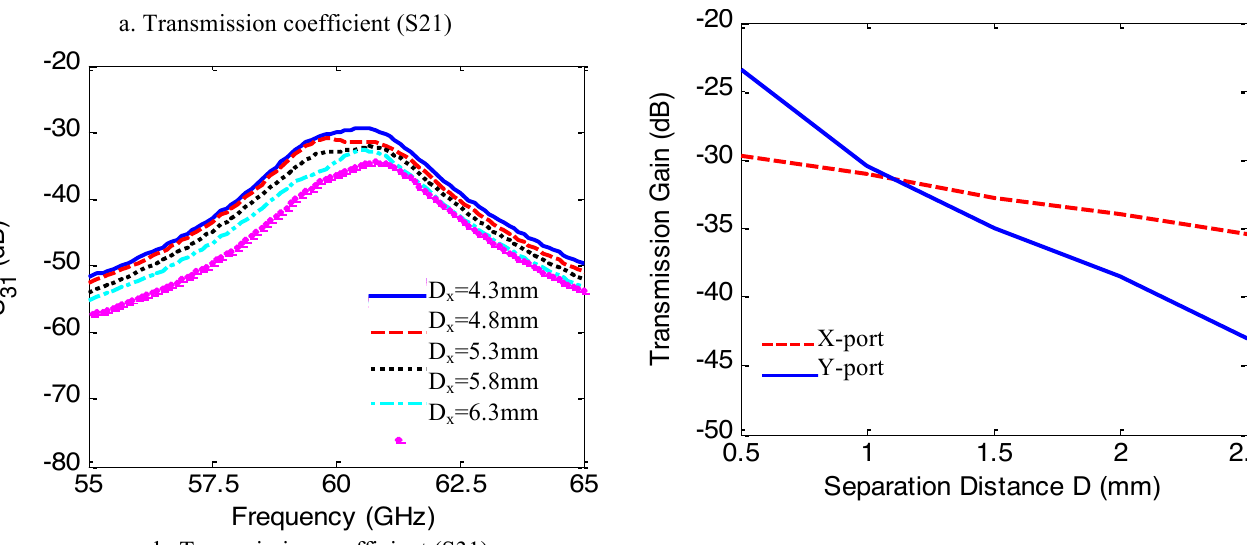
Fig. 12. The transmission gain versus frequency and the transmission gain versus separation distance between the CP-microstrip on-chip antenna (port 1) and the dual- polarized on-chip antenna (Y-port (2) and X-port (3)) versus separation distance D at 60